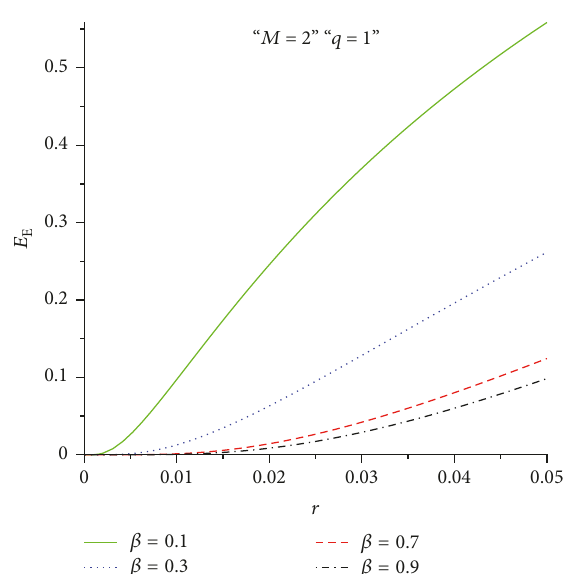
Figure 3: Energy distribution near zero obtained in the Einstein prescription for different values of 𝛽